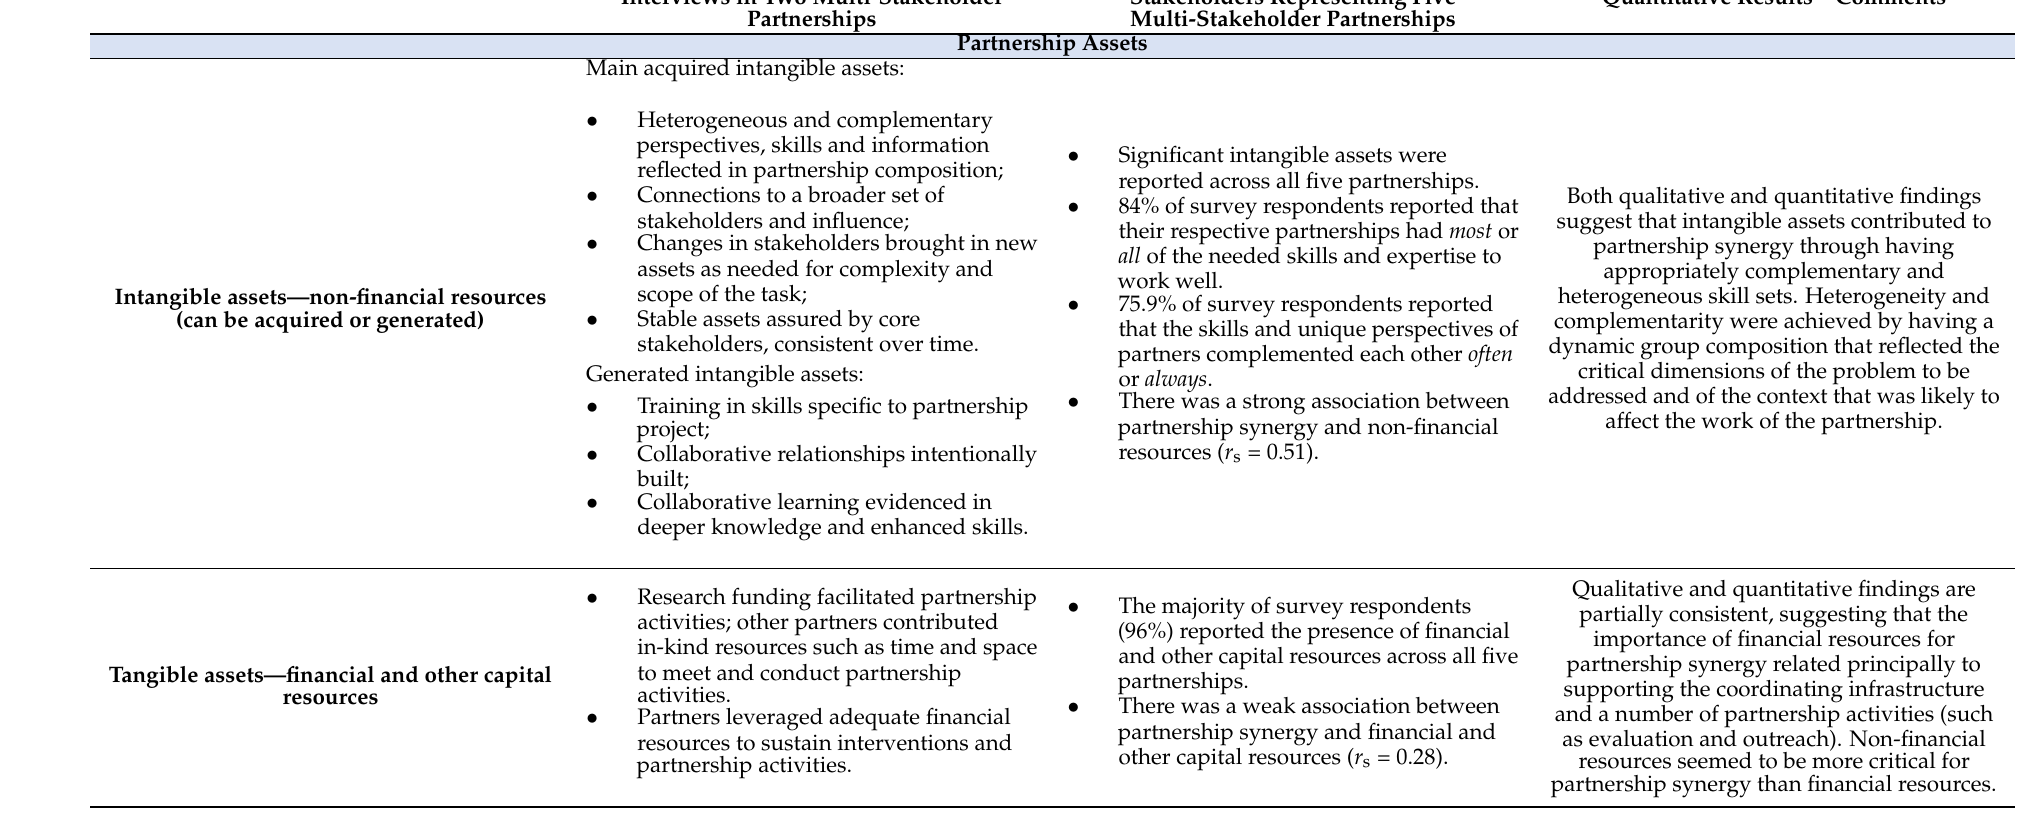
Determinants of Partnership